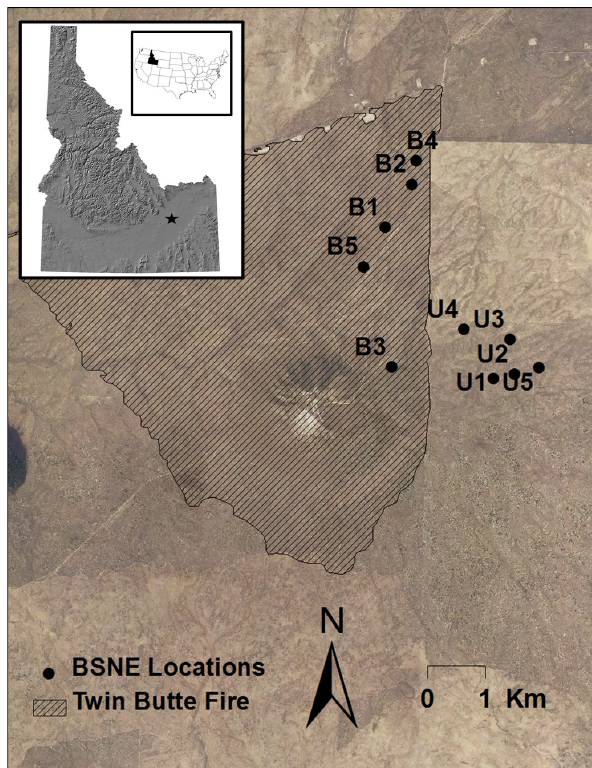
Fig. 1. (A) Location of study area relative to Idaho, with inset show- ing location of Idaho relative to USA. (B) Aerial photograph of the eastern Snake River plain (ESRP), Idaho, showing the area burned by the Twin Buttes wildfire in 2007 (hatched area), and the location of aeolian sediment collectors in the burned (B) and unburned (U)